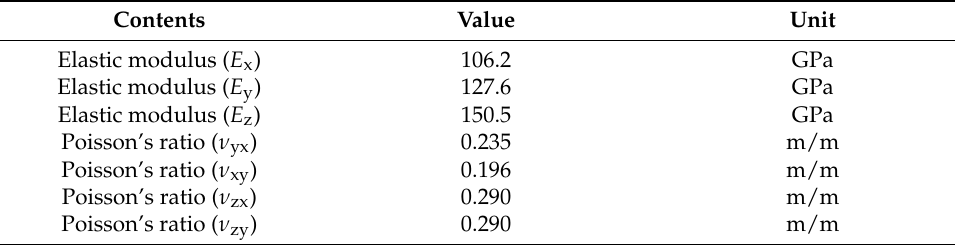
Table 4. Equivalent properties with simulation for elliptical pores.